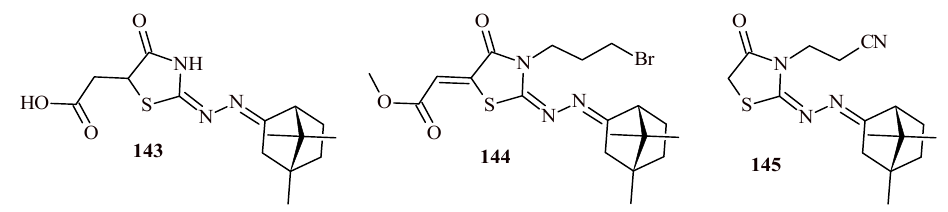
Figure 54. The structures of camphor-thiazolidine-4-one hybrids.